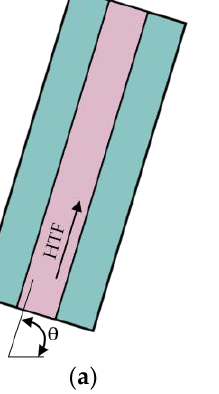
Figure 3. Inclined double-tube arrangements; ( a ) Case DTI-B-M; ( b ) Case DTI-B-S.